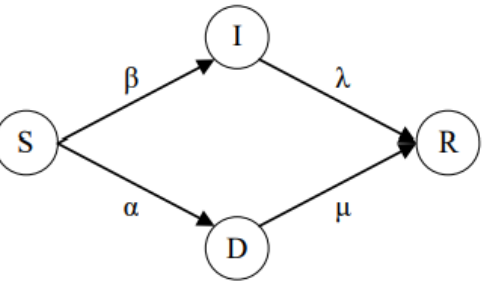
Figure 2. Node state transition of SDIR